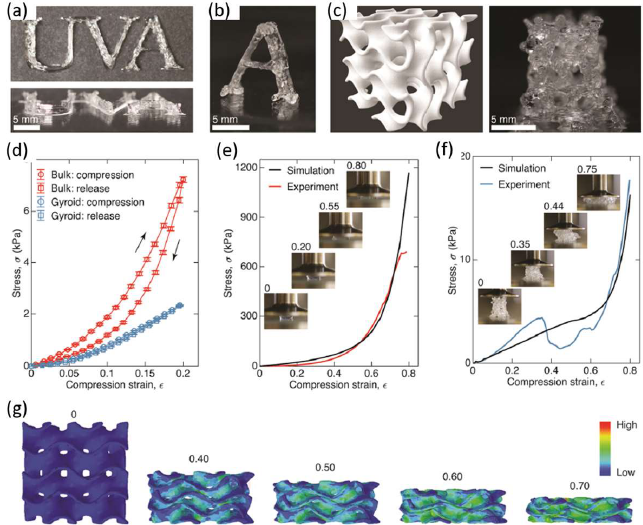
Figure 10. Direct-write printing soft elastomers to create deformable 3D structures. ( a ) 3D printed UVA initials with a stack thickness of 2 mm. Upper: bird’s eye view; lower: side view. ( b ) Free- standing, 3D printed letter “A”. ( c ) 3D rendering of a cubic gyroid (left) and the corresponding printed product with dimensions 10 × 10 × 10 mm 3 (right). ( d ) For the bulk sample, the compression − release profile exhibits a hysteresis associated with 23% energy dissipation (dashed lines), whereas for the gyroid, there is almost no energy dissipation, as evidenced by the complete overlap between the compression and release profiles (solid lines). The apparent Young’s modulus, E = σ / ε , of the gyroid is about 8 kPa, nearly half of 20 kPa for the bulk; this is likely because the porous gyroid has a